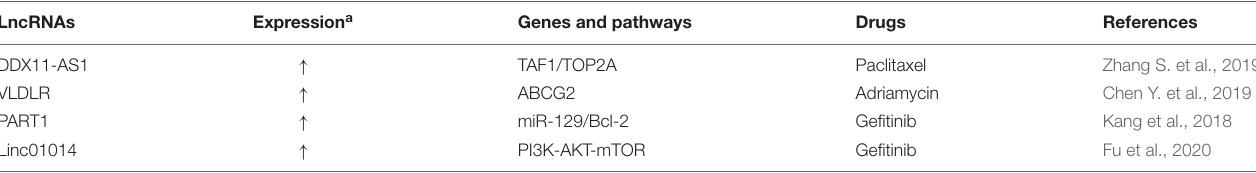
TABLE 6 | Long non-coding RNAs (lncRNAs) and resistance to other drugs in esophageal cancer. LncRNAs